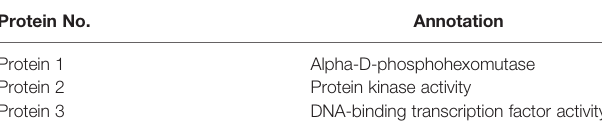
TABLE 3 | Proteins interacting with DpAP2. Protein